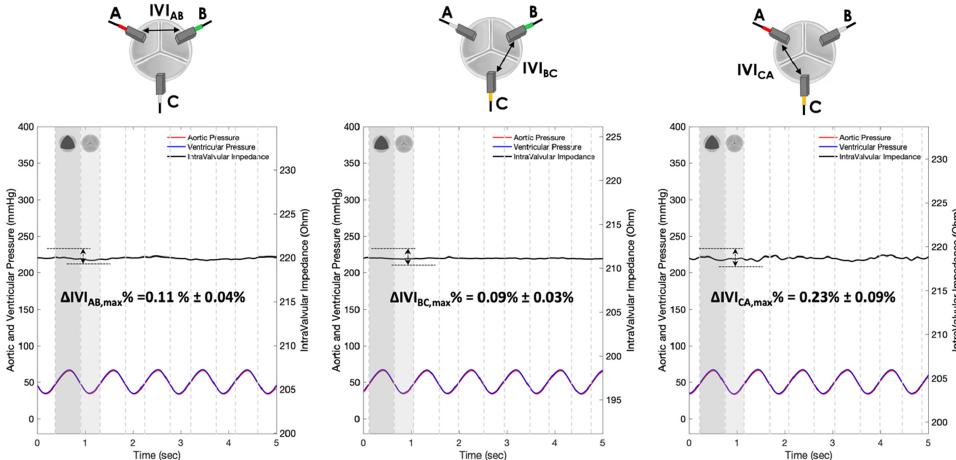
Figure 13. IVI measurements recorded for the three pairs of electrodes of Prototype 1 under altered leaflet dynamics: AB ( left ), BC ( center ) and CA ( right ).